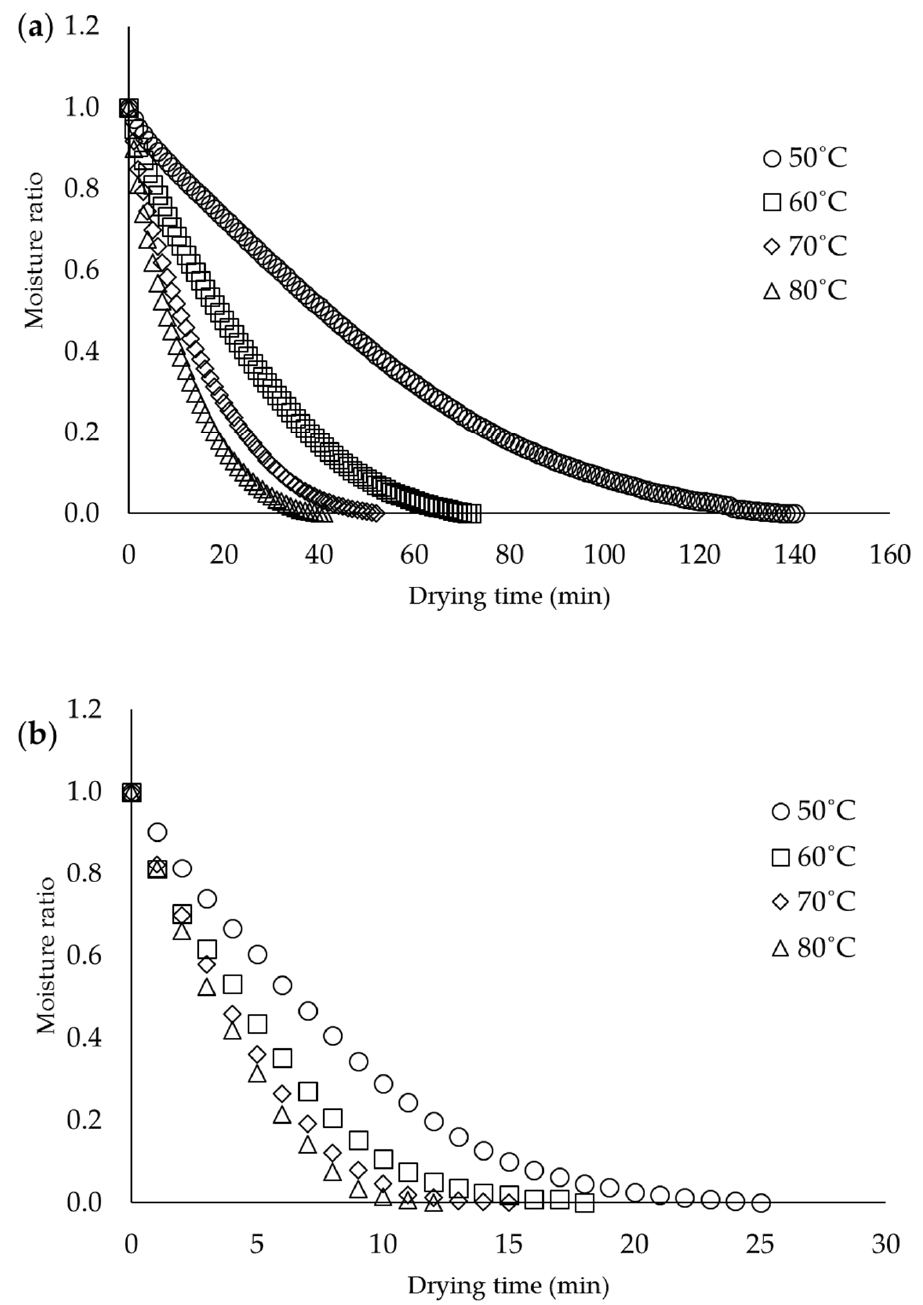
Figure 1. Variation in MR with drying time at various ( a ) oven drying and ( b ) IR drying